Question: Summarize what this figure shows in one sentence.
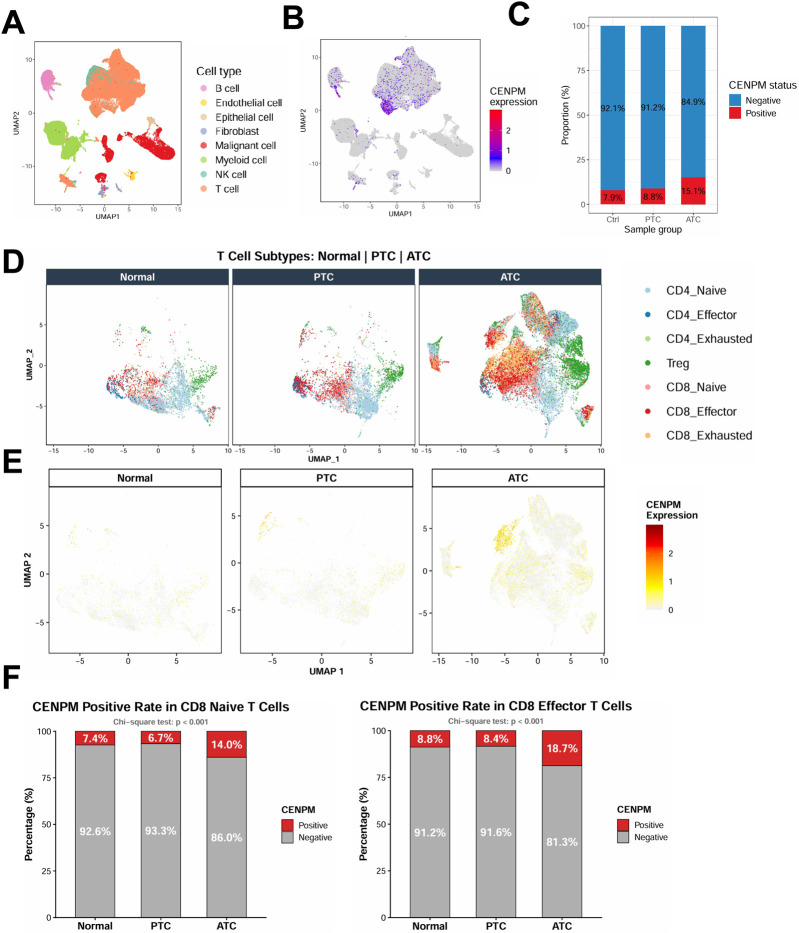
Answer: Single-cell analysis of CENPM in the GSE193581 dataset (A) UMAP visualization of major cell populations in thyroid tissues (B) CENPM expression levels across cell types, showing relatively high expression in T cells (C) Comparison of T cell infiltration proportions among normal, PTC, and ATC samples (D) UMAP plot of T cell subtypes identified across tissue origins (E) Overall proportion of CENPM-positive T cells in normal, PTC, and ATC (F) Percentages of CENPM-positive cells within CD8 + naive and CD8 + effector T cell subsets across normal, PTC, and ATC.